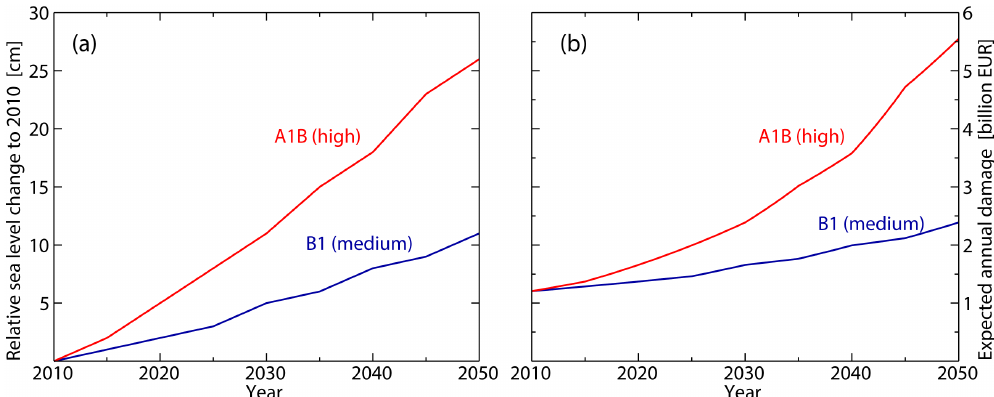
Figure 5. (a) Mean sea level projections for the SRES scenarios A1B (high climate sensitivity) and B1 (medium climate sensitivity) in Copenhagen provided by the DIVA tool (Hinkel and Klein, 2003; Vafeidis et al., 2008). (b) The expected annual damage as a function of time, based on the two